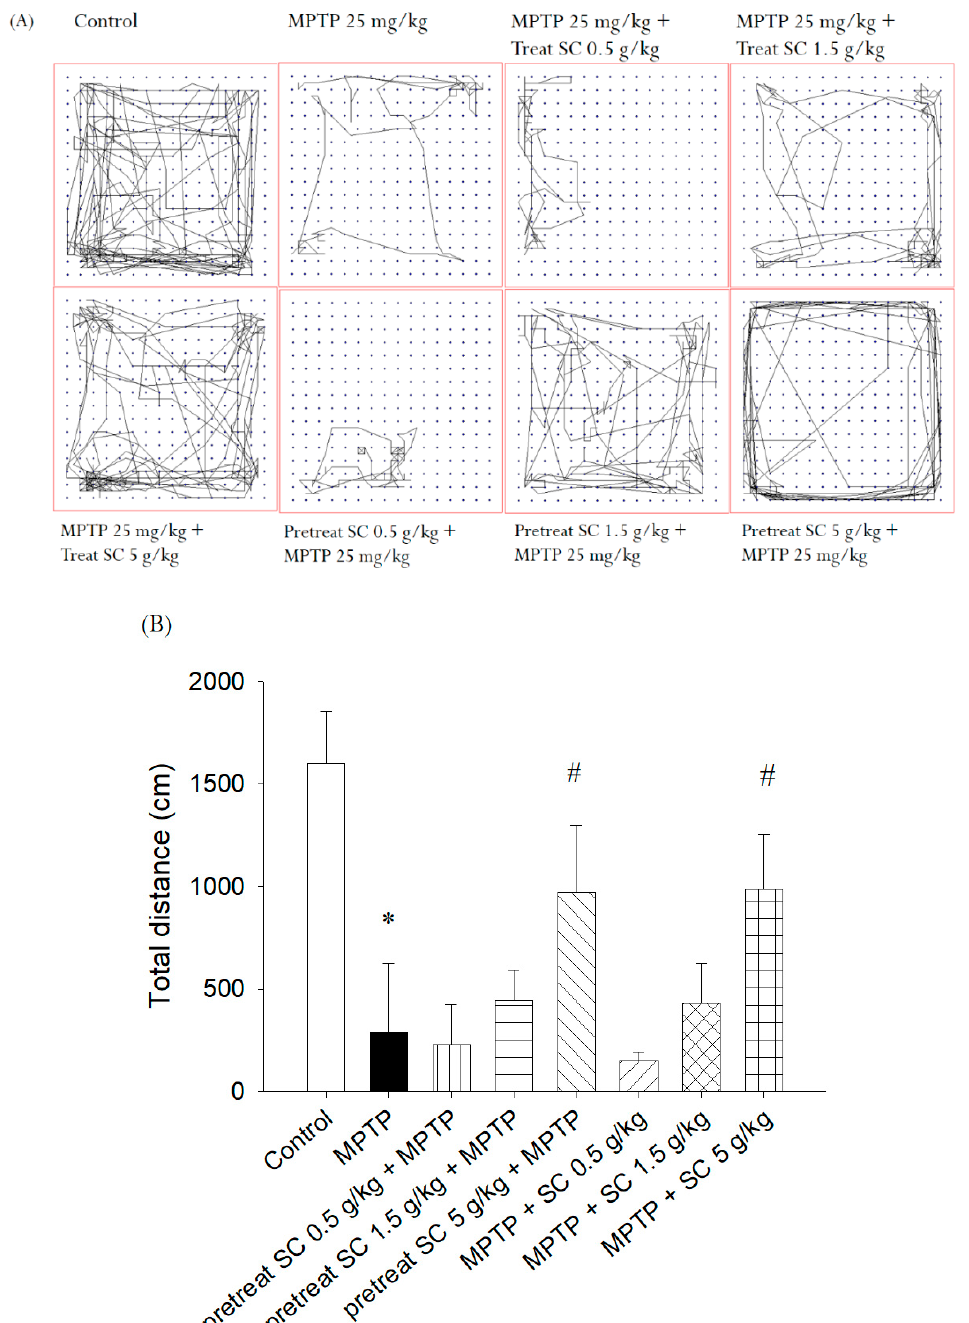
Figure 4. Effect of S. chinensis on total distance traveled as determined by movement traces in the open field test. ( A ) Mice exploring behavior in the open field test; ( B ) total distance within the experimental time. The movement distance of the MPTP-only group was significantly reduced compared with that of the control group; however, this reduction in motor activity was attenuated by pretreatment and treatment with high-dose S. chinensis (5 g / kg) compared with the MPTP-only group. The data are expressed as the mean ± S.D. ( n = 6). * p < 0.001 compared with the control group; # p < 0.005 compared with MPTP group as determined by t -tests. MPTP, 1-methyl-4-phenyl-1,2,3,6-tetrahydropyridine; SC: Schisandra chinensis